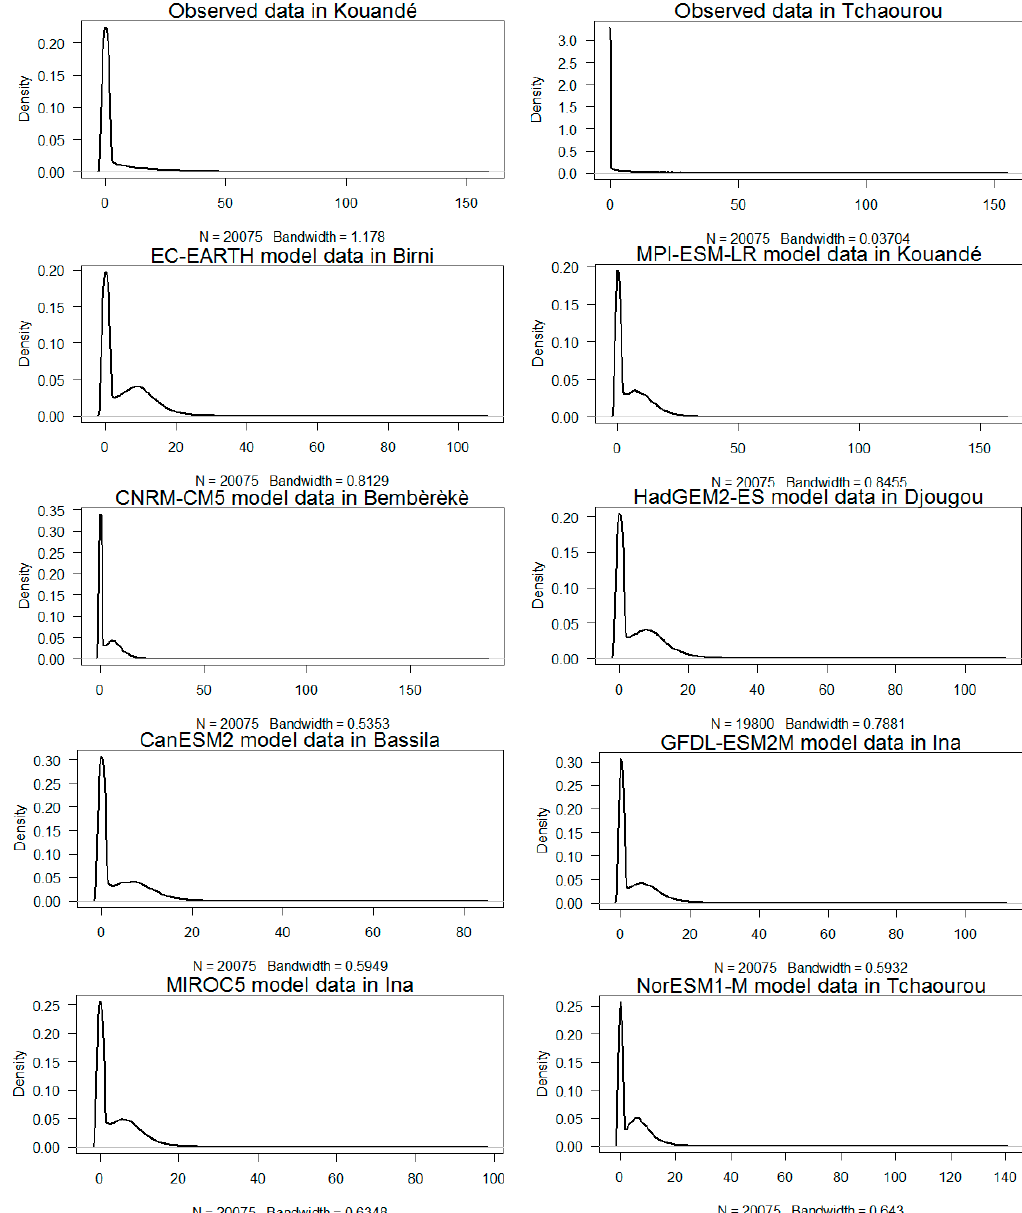
Figure 3. Density of observed and simulated